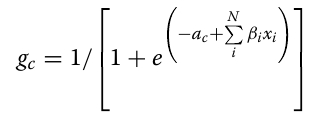
tional file 1: Table S5). The above model has a predictive power of 73% for class I (mRS 3–5) and 64% for class II (mRS 6).